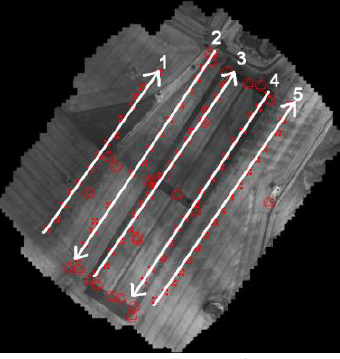
Figure 5. Image block and flight lines.